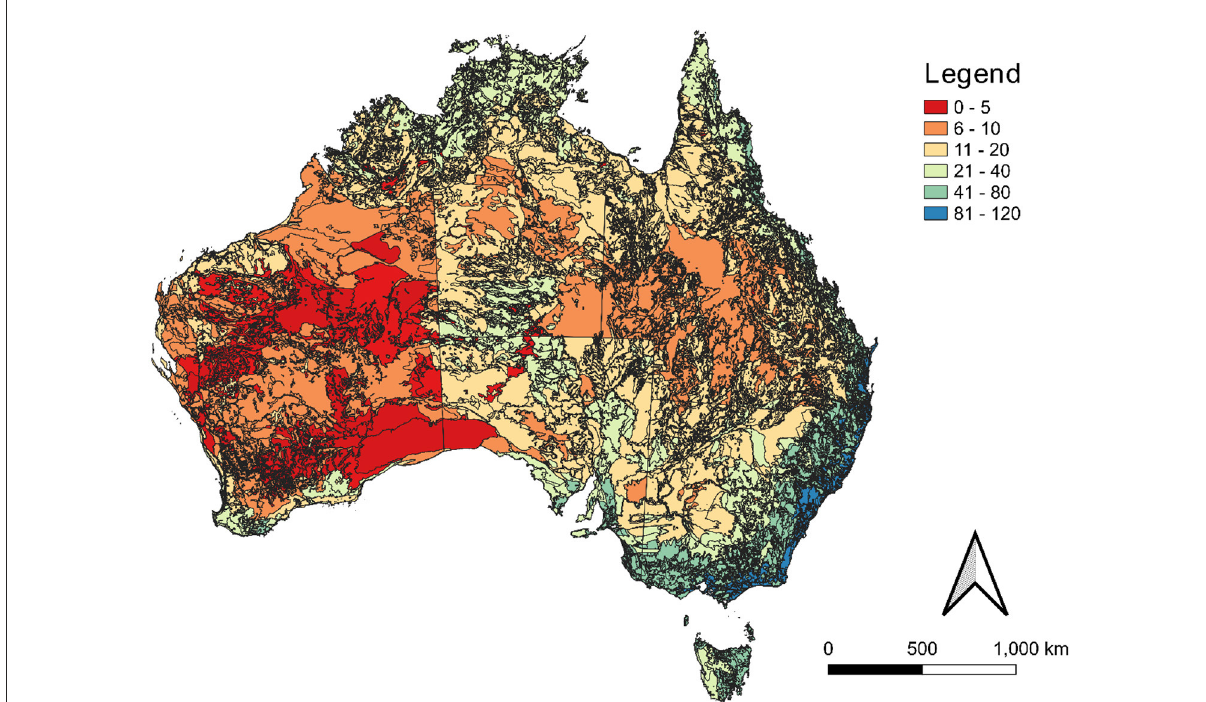
FIGURE1 The potential number of native plant food and forage species predicted to be suitable across Australia, with locations delineated by soil order mapping and IBRA mapping (McKenzie et al., 2012; IBRA,